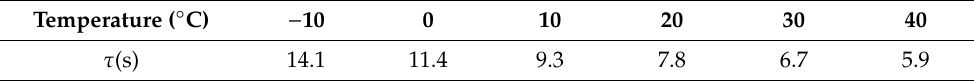
Table 3. Measurement of τ at typical temperature.